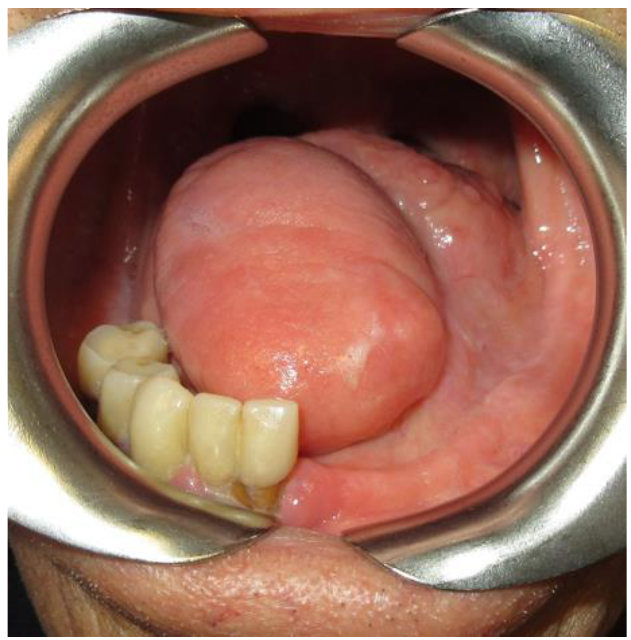
Figure 4. Hemiglossectomy. Figure 4.